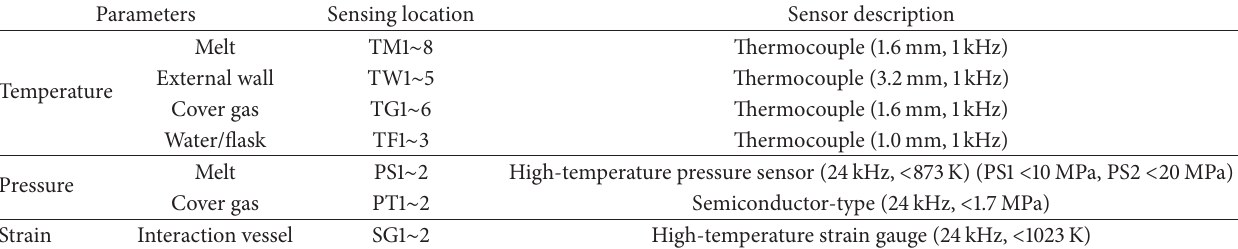
Table 1: Measurement parameters and their descriptions.